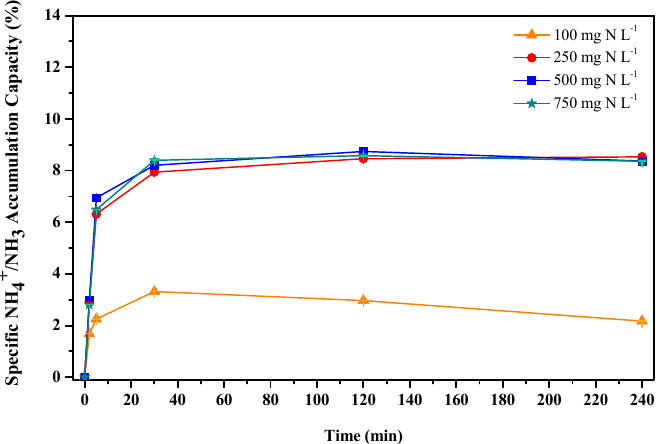
Figure 5. Specific ammonium/ammonia accumulation capacity (%) of 3-day-starved cells upon inoculation in various substrate concentrations Incubation conditions included temperature of 25 °C, initial NH 4+ -N concentration of 250 mg N L − 1 , and cell density of 600 mg TSS L − 1 , equivalent to 1.29 × 10 9 cells mL − 1